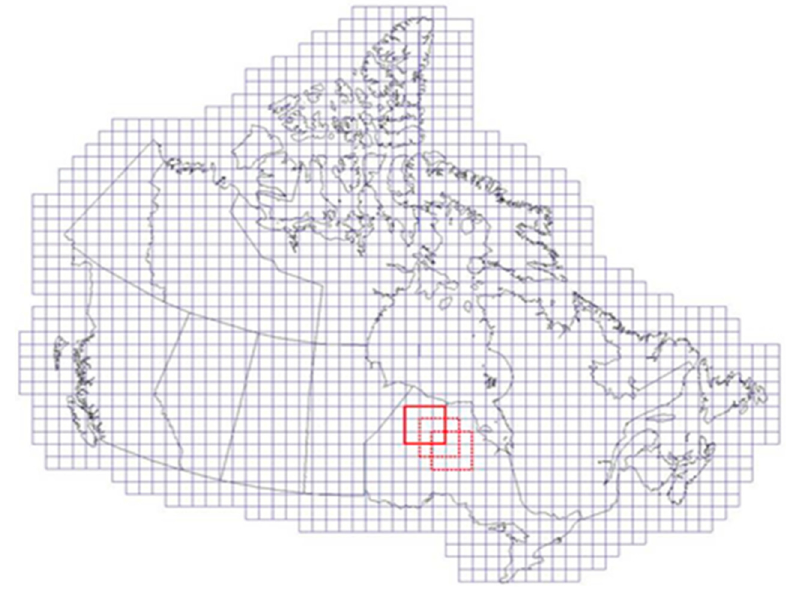
Figure 2. Configuration of the local optimization windows.